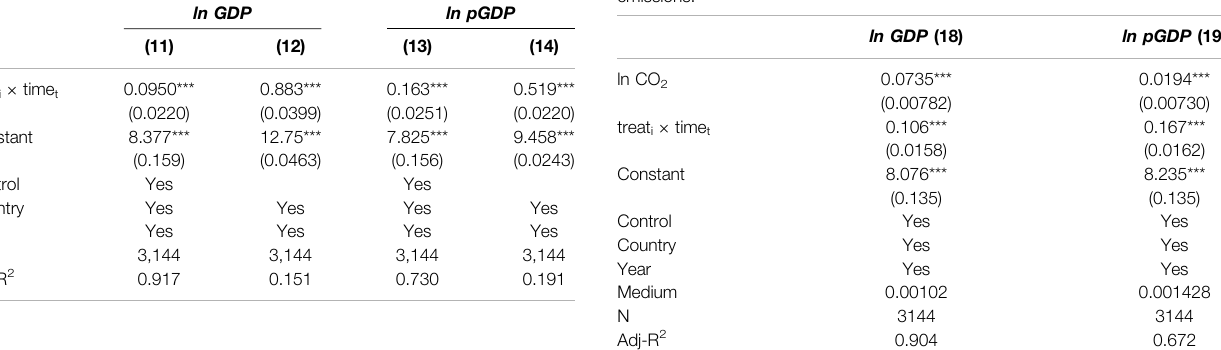
TABLE7| Roleofforestresourceprotectiononeconomicgrowththroughcarbon